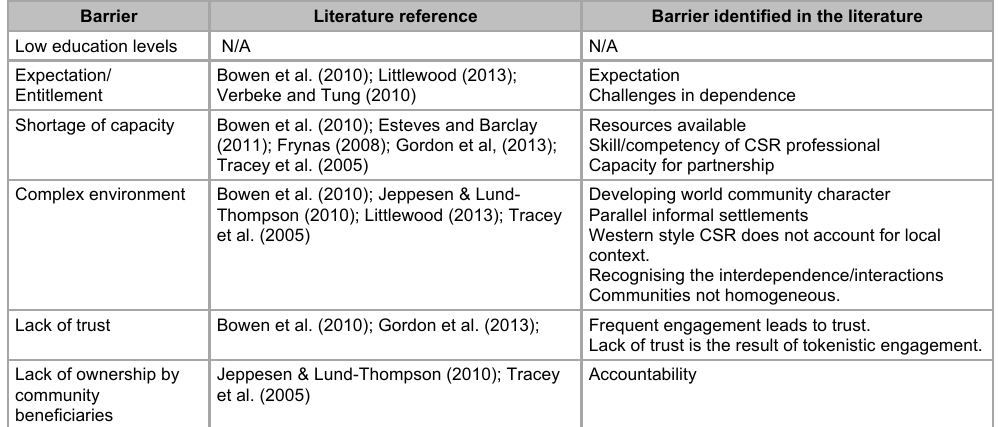
Comparison of barriers found in research and